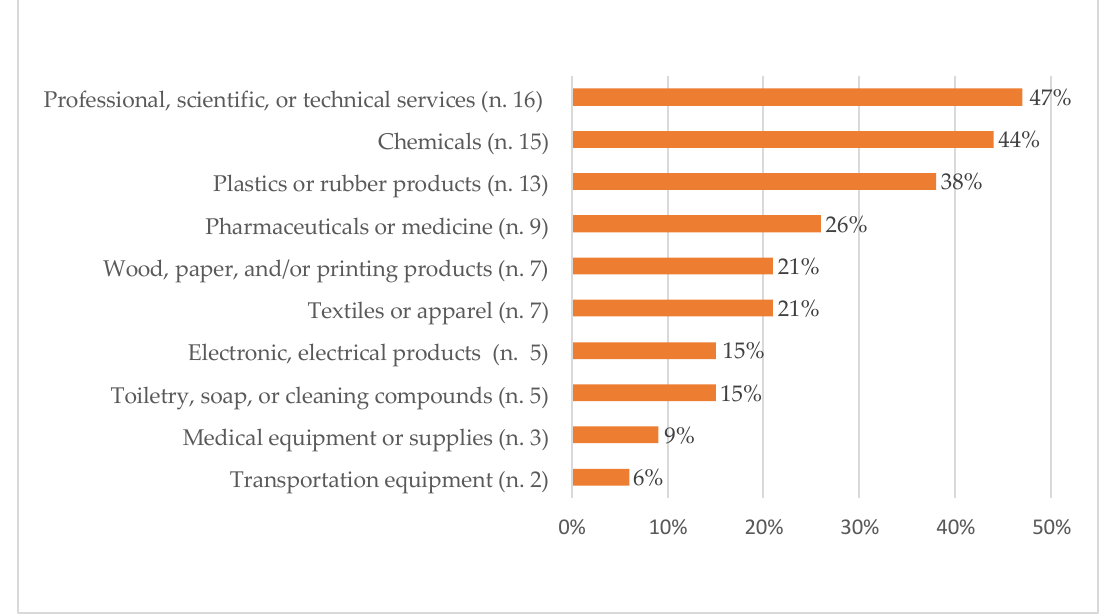
Figure 2. Commercial sectors where engineered nanomaterials or nano-enabled products/services were intended to be used ( n = number of respondent companies); percentages.